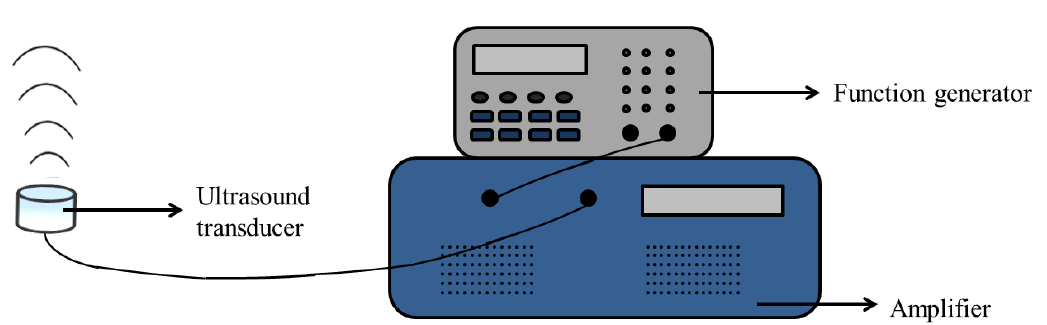
Figure 1. Ultrasound apparatus. The ultrasound transducer with a diameter of 2.0 cm was fixed with aluminum block by a rubber band to keep the transducer facing upward in the degassed water tank.